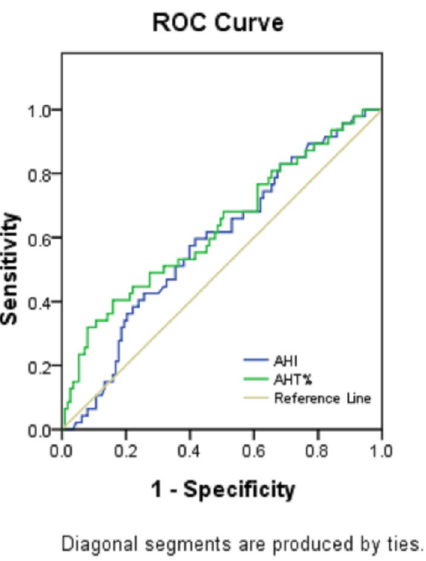
Figure 2. ROC curve analysis for AHT% and AHI for predicting ESS ≥ 11 in patients with OSA. The prediction performances of AHT% and AHI were assessed for clinically significant EDS (ESS ≥ 11). AHT% demonstrated a higher predictive accuracy than AHI for ESS ≥ 11.